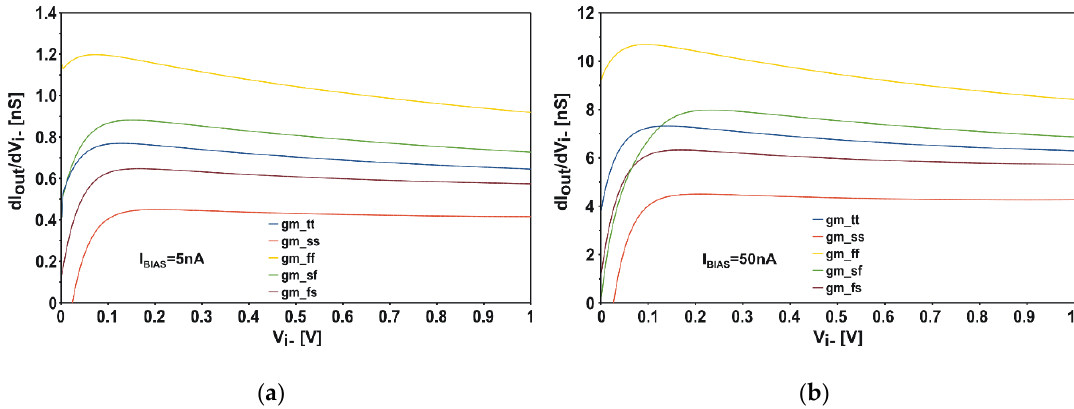
Figure A1. Corner simulations of the amplifier of Figure 3 at the asymmetrical input drive: ( a ) for 5-nA I BIAS ; ( b ) for 50-nA I BIAS . V DD is 1 V.